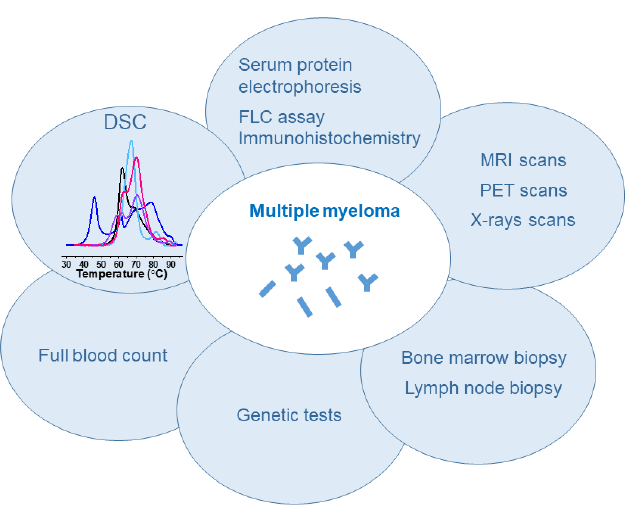
Figure 6. Schematic representation of interdisciplinary approach for MM diagnosis involving DSC as a complementary tool to clinical tests.